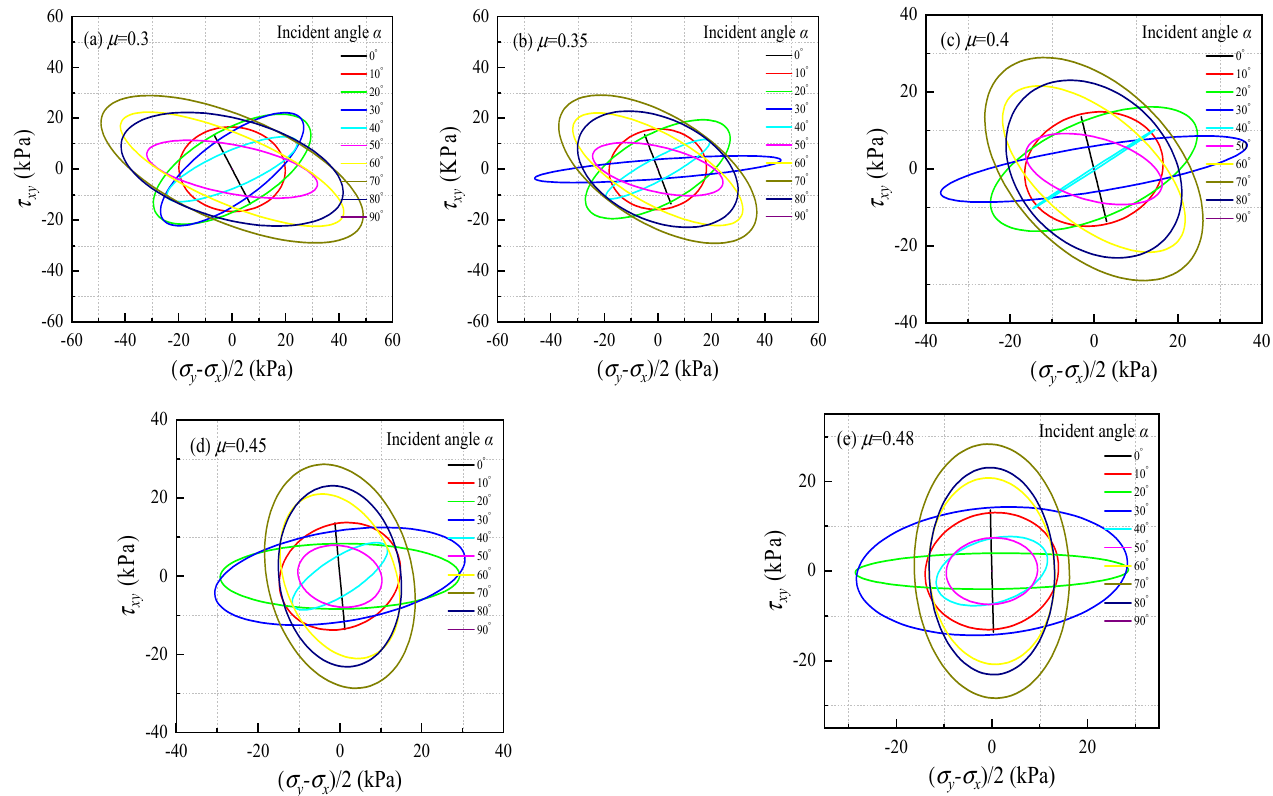
α is roughly the same for var- α is about 30°; α is about 45°; subsequently, L a